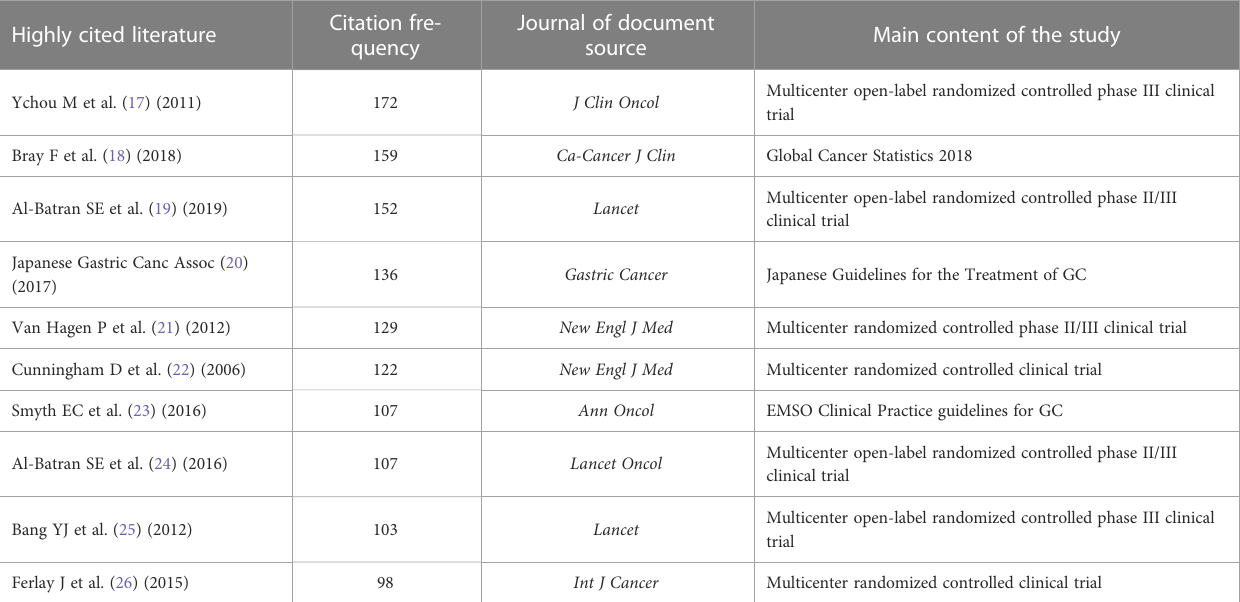
TABLE 1 Top 10 co-cited articles related to GC neoadjuvant